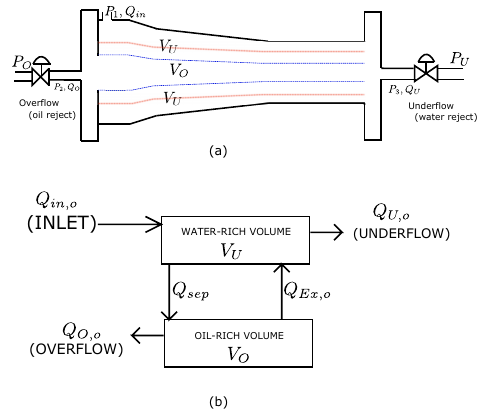
Figure 1: Simplified diagram of a hydrocyclone liner representing the ‘oil-rich volume’ ( V O ) and the ‘water-rich volume’ ( V U ) (shown in (a)) and a block diagram representation of a control-oriented model making use ( V O ) and ( V U ) (shown in